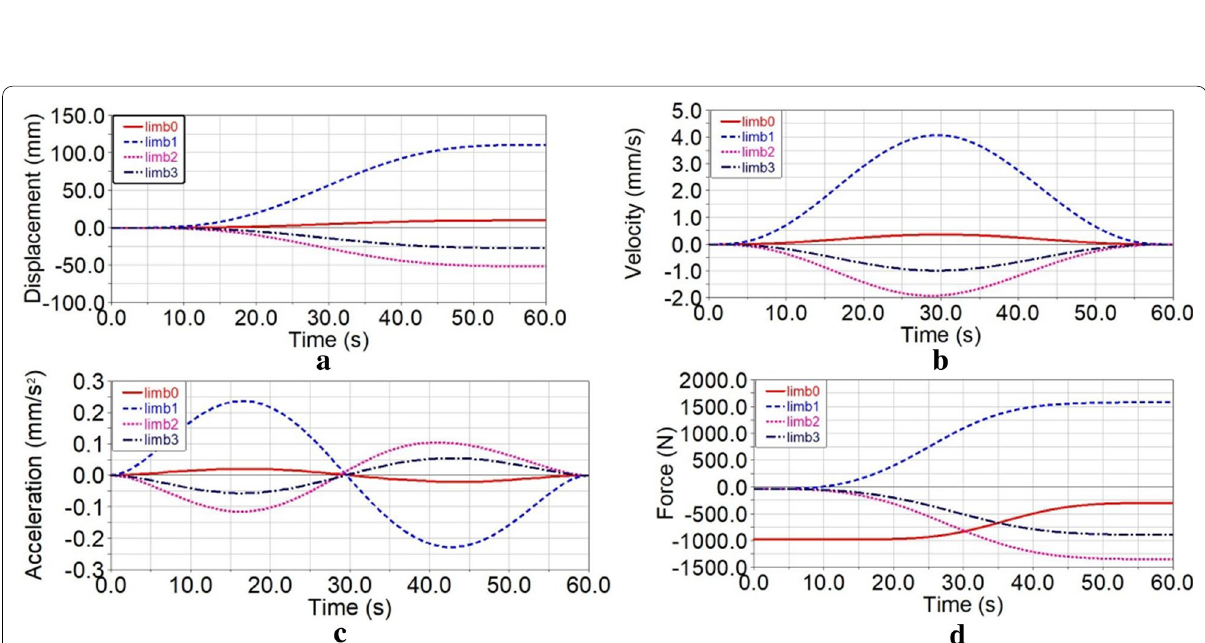
Figure 9 a Displacement, b velocity, c acceleration, and d driving force of each limb of module